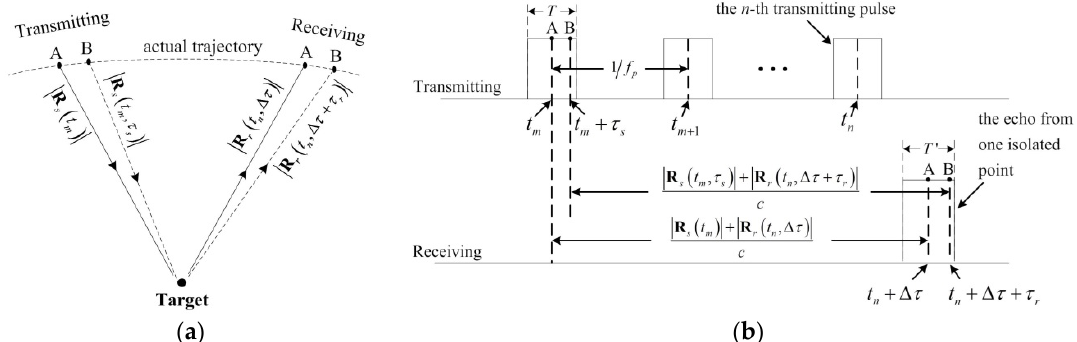
Figure 1. ( a ) The actual relative motion between spaceborne Synthetic Aperture Radar (SAR) and the target; ( b ) The corresponding time sequence of transmitting and receiving.